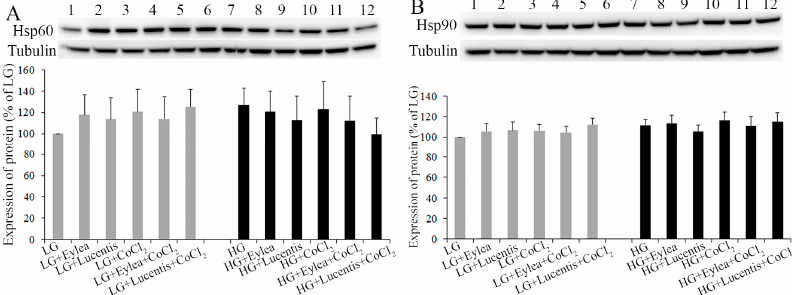
Figure 5. Effects of aflibercept and ranibizumab on Hsp60 and Hsp90 expression in Müller cells under stress conditions. Müller cells were incubated in stress media for 24 h. The effects of aflibercept and ranibizumab on Hsp60 ( A ); and Hsp90 ( B ) expression were studied by Western blots, n = 4/group.